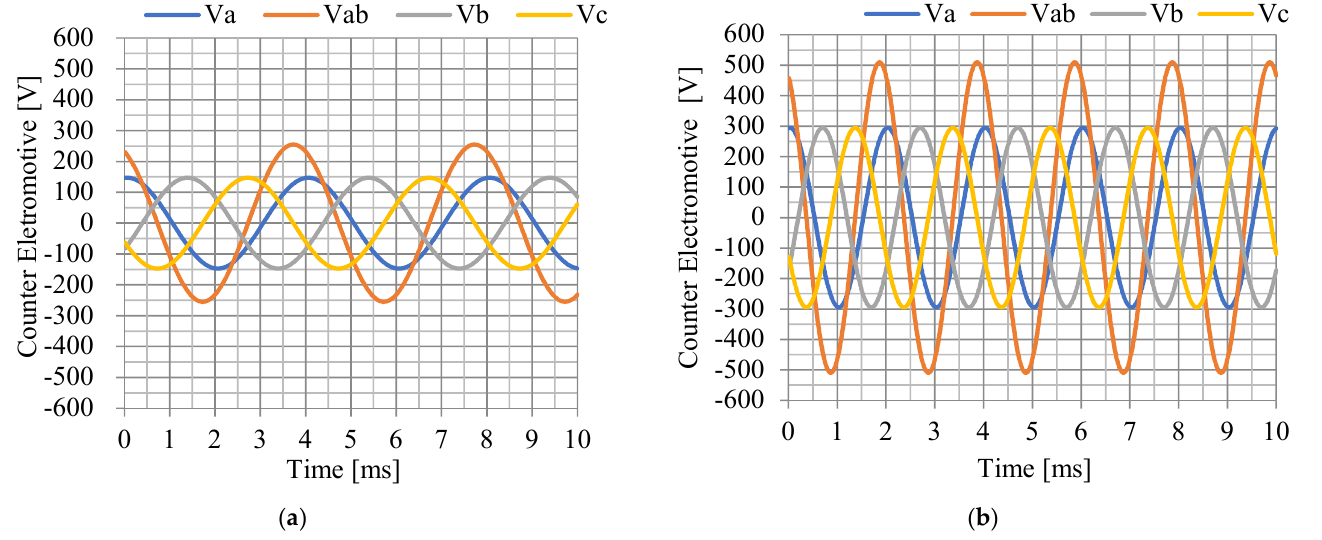
Figure 8. Back-EMF when open circuit. ( a ) 15 krpm. ( b ) 30 krpm.